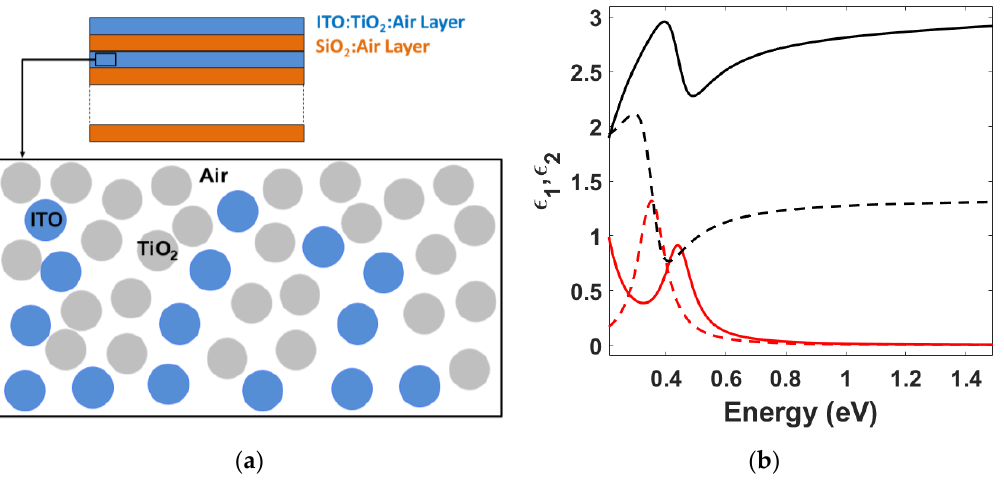
Figure 1. ( a ) Sketch of an indium tin oxide (ITO):TiO 2 :air layer, with ITO nanoparticles (blue dots), TiO 2 nanoparticles (grey dots), and air (white interstitial volume); ( b ) real part (solid black curve) and imaginary part (solid red curve) of the dielectric function of a ITO:TiO 2 :air (20:50:30 ratio) layer, calculated with the Rayleigh mixing formula, and real part (dashed black curve) and imaginary part (dashed red curve) of a ITO:air (20:80 ratio) layer, calculated with the Bruggeman approximation. In Figure 1b, the dashed curve represents the real (black) and imaginary (red) part of the dielectric function of an ITO:air two-phase mixture, which is a dispersion of ITO nanoparticles, with a filling factor of 0.2, in air. This two-phase mixture refractive index is determined with the Bruggeman effective medium theory [23,24]. Instead, the solid curves in Figure 1b represent the real (black) and imaginary (red) part of the effective dielectric function of an ITO:TiO 2 :air mixture. It is clear that the resonance related to the ITO plasmonic peak shows a splitting, and one resonance shifts towards higher energies in the three-material mixture evidencing the possibility to further tailor the optical response of ITO nanostructures.